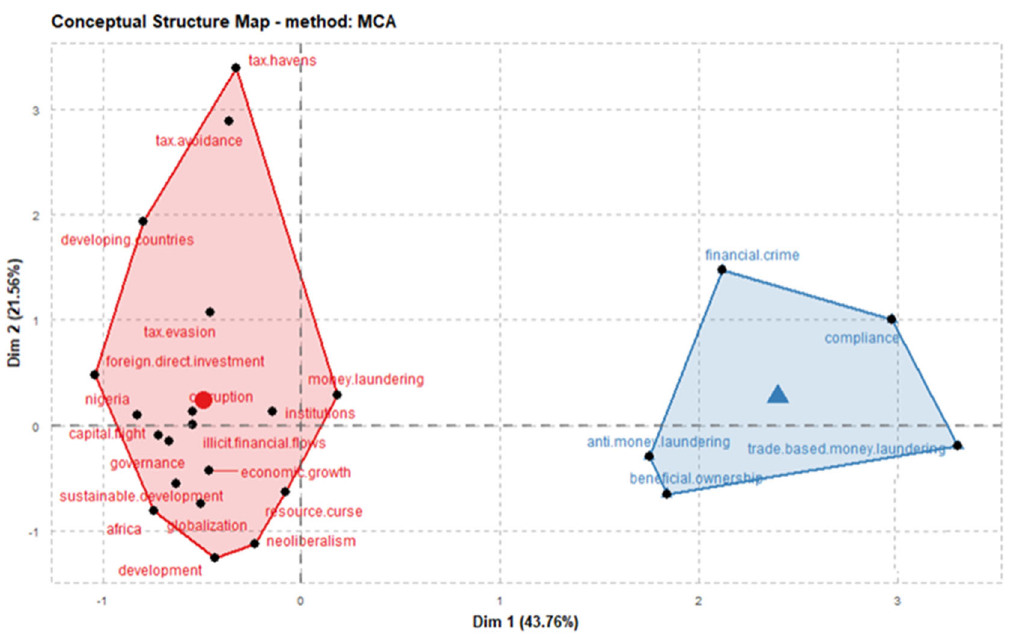
Figure 5. Bibliometric analysis of 687 data records—factorial analysis. Source: Scopus/Biblioshiny.